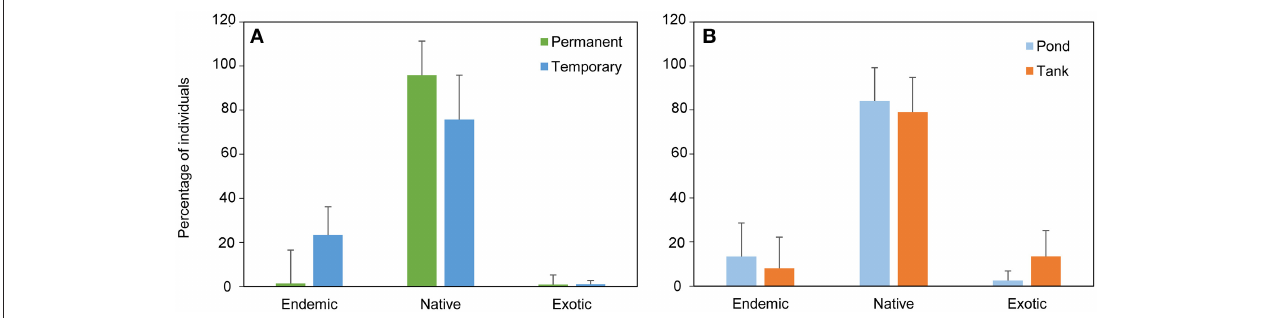
FIGURE 2 | Mean percentage of individuals of exotic, native and endemic species found (A) in the temporary and permanent ponds during the monthly sampling, and (B) in the natural ponds and artificial tanks during the extensive sampling.